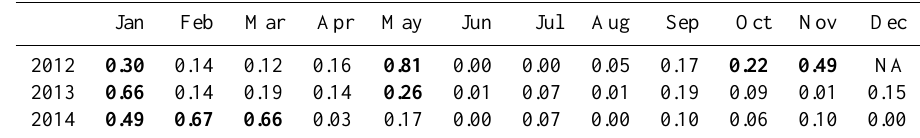
Figure 6. Top: (cid:49) CO 2 observed (i.e., observations minus background; red), along with the modeled (cid:49) CO 2 convolution (blue). Bottom: monthly average comparisons between the model (blue) and observations (red line and circles) for each year. Error bars on the observations represent the average background uncertainty. Table 1. Coefficient of determination ( R 2 ) between (cid:49) CH 4 and (cid:49) CO in each month. Months with R 2 > 0.2 are in